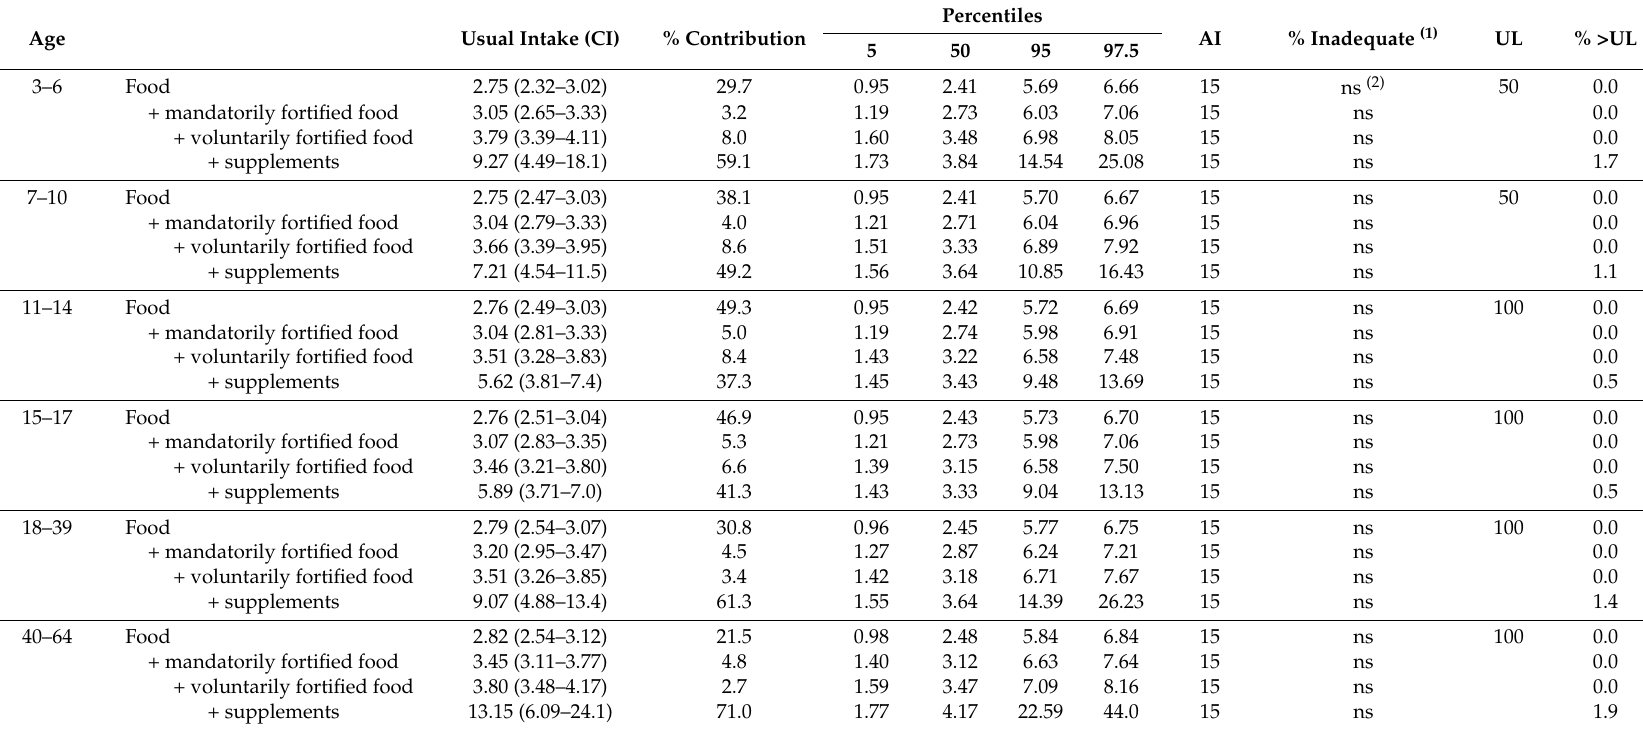
Table 6. Usual intake of vitamin D ( µ g/day) from food, fortified food and supplements in Belgian women (3–64 years), Belgian study on the intake of vitamins A, D, E and K (VITADEK-study)